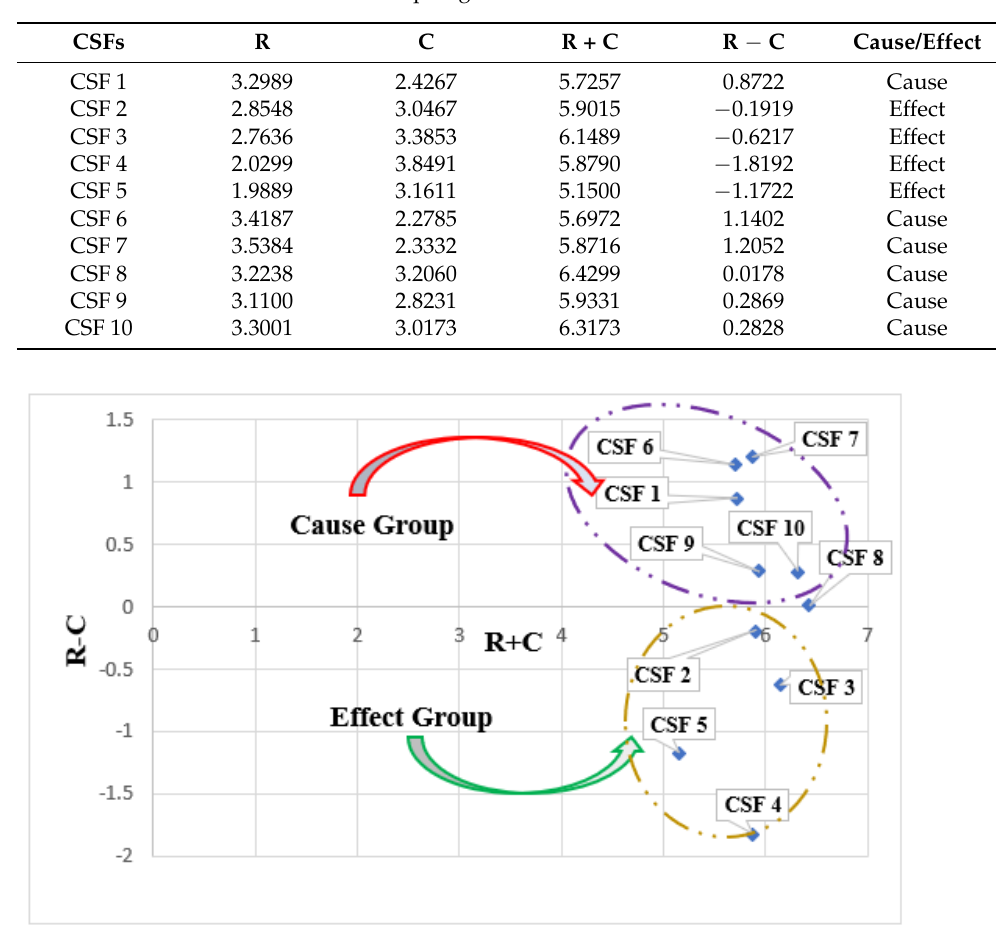
Table 7. Cause and effect of CSFs to adopt logistics 4.0.